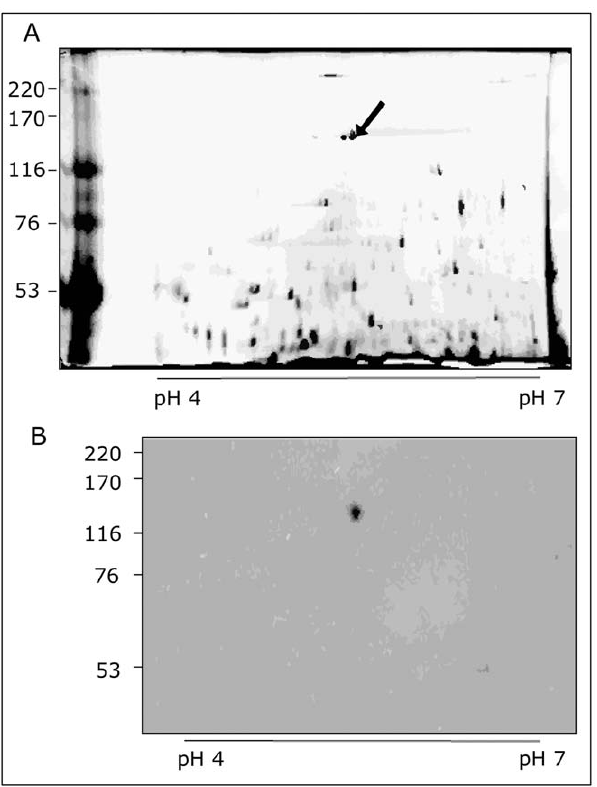
Figure 3. Ligand blotting showing the salivary gland proteins of Oncopeltusfasciatus recognized by biotin-tagged membrane proteins and live biotinylated parasites. ( Lane a ) Coomassie Blue staining of total salivary gland proteins separated by 12% SDS-PAGE. The numbers on the left indicate the relative position of molecular mass markers expressed in kilodaltons. ( Lane b ) Ligand blotting that shows the presence of a 130 kDa protein recognized by biontinylated live parasites. Prior to the incubation with the membrane, the parasite surface proteins were tagged with Sulfo-NHS-Lc-Biotin. The arrow indicates the position of the 130 kDa protein. For further details see the Methods.